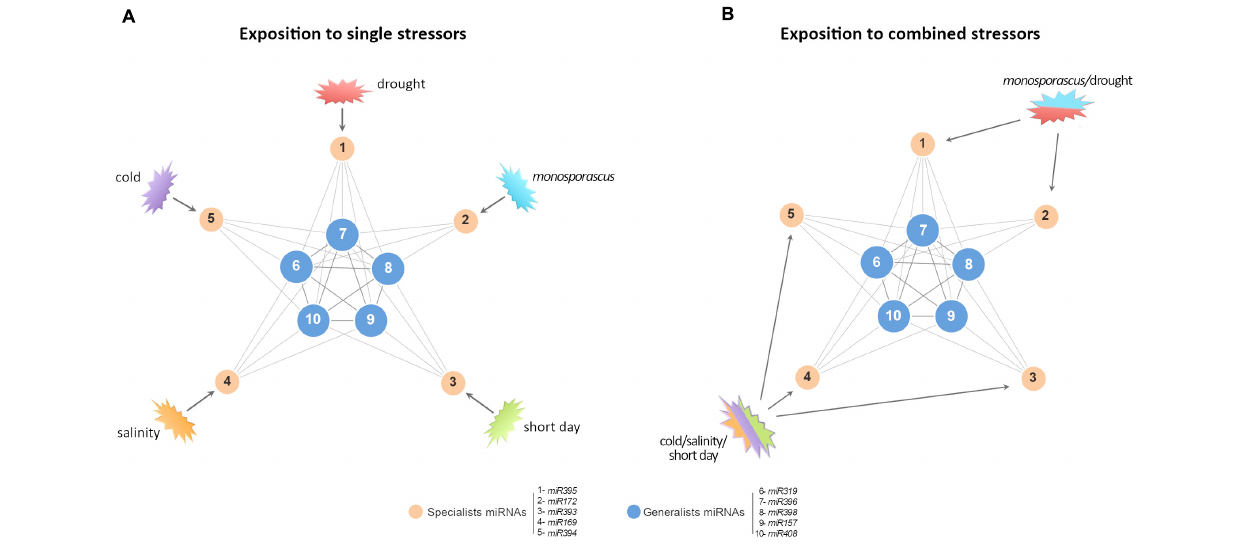
FIGURE 6 | A proposed model to explain predominant non-additive response in certain miRNAs families. (A) Simplified graphic representation of the proposed miRNA-mediated network of response to stress in melon (Sanz-Carbonell et al., 2019, 2020). Blue nodes represent highly connected miRNAs with a broad response range to biotic and/or abiotic stress conditions ( generalists ). Orange nodes represent miRNAs reactive to specific stress conditions ( specialists ). Numbers indicate representative miRNAs for each functional group. (B) When the network is exposed to double (for example, Monosporascus /drought) or triple (cold/salinity/short day) stress conditions, it is expected that the stresses combinations should not affect specialist miRNAs (poorly connected between them), and, consequently, they exhibit additive SCE values (comparable to the resultant of the sum of both individual responses). In contrast, generalist miRNAs (highly interconnected) respond to stresses combination in a differential (non-additive) manner, related to each stress